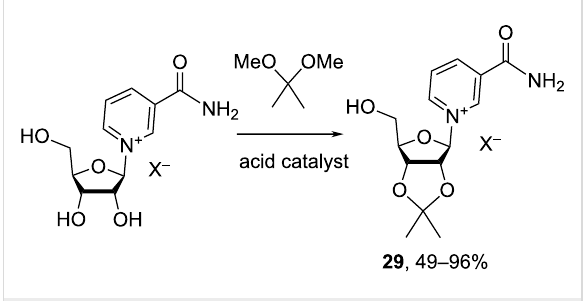
Scheme 14: Efficacious protection of 2 ′ ,3 ′ -hydroxy groups of NR + X − .